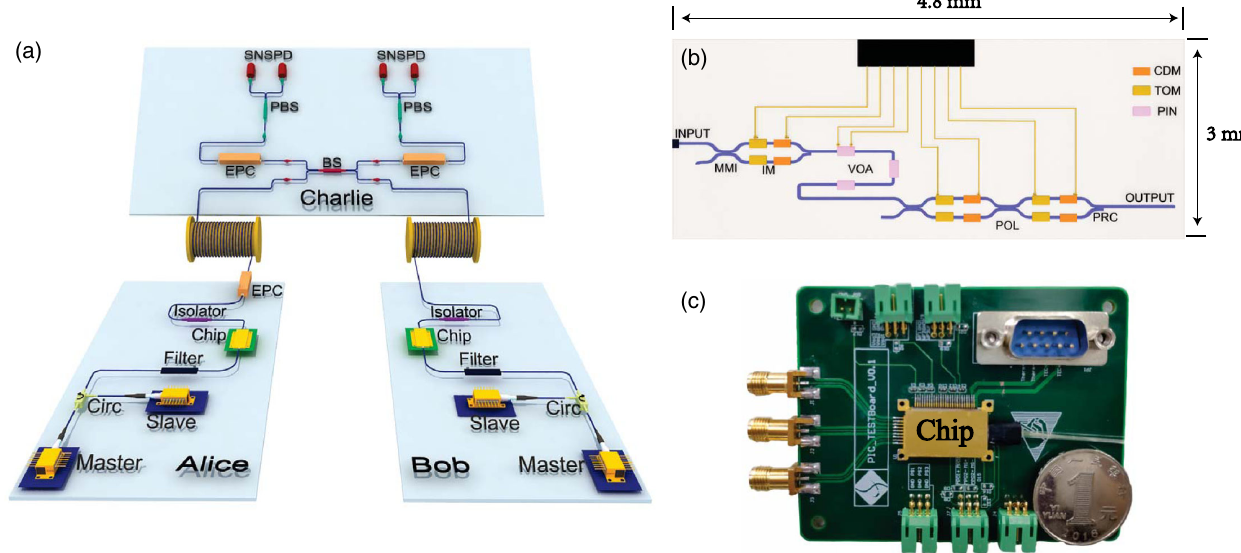
FIG. 2. (a) Experimental setup of chip-based MDI QKD. Alice and Bob each possess a master gain-switched laser (master) which injects photons into the cavity of a slave gain-switched laser (slave) through a circulator (circ) to generate low-jitter phase-randomized light pulses at a repetition rate of 1.25 GHz. The generated pulses are coupled into a silicon photonic transmitter chip (chip) which integrates together an intensity modulator, variable optical attenuator, and polarization modulator. The Bell-state measurements are performed by the untrusted relay Charlie who comprises a beam splitter (BS), two electric polarizing controllers (EPCs), two polarizing beam splitters (PBSs) and four superconducting nanowire single-photon detectors (SNSPDs). (b) The schematic of the Si chip. All components are fabricated using standard Si blocks, including multimode interference (MMI) couplers, thermo-optics modulators (TOMs), carrier-depletion modulators (CDMs), and polarization rotator combiner (PRC). (c) Image of the packaged chip soldered to a compact control board.